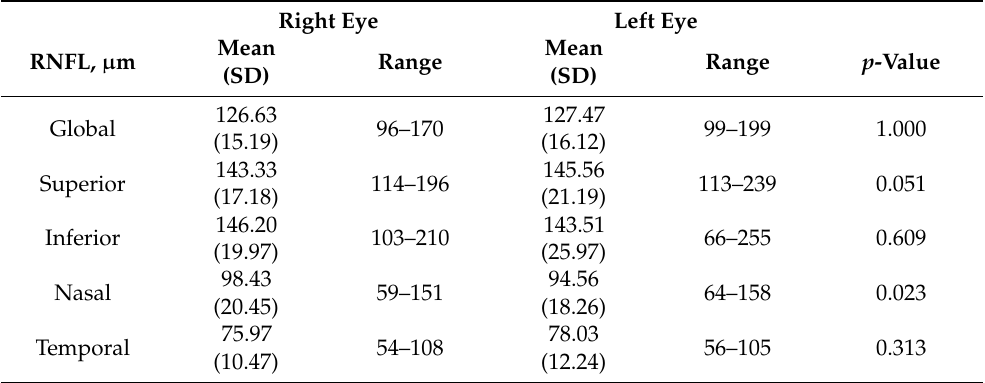
Table 4. Global and sectorial RNFL thickness means filtered by eye laterality on Revo80 measure- ments.